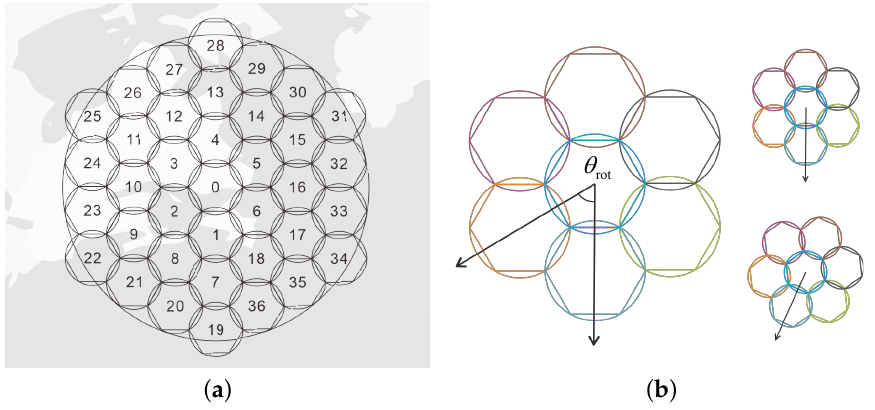
Figure 8. Layout of NGSO satellite beams and illustration of rotation angle. ( a ) Layout of NGSO satellite beams with 37 beams; ( b ) Illustration of rotation angle for seven-beam